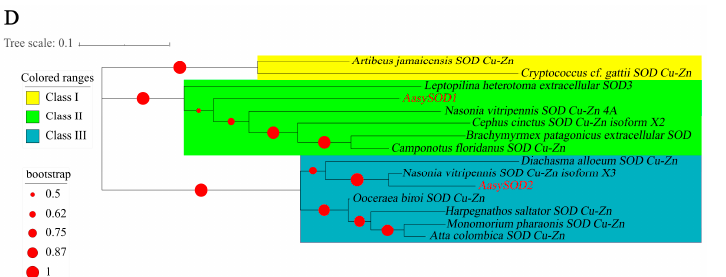
Figure 2. Phylogenetic analysis of antioxidant enzymes in insects: ( A ) catalase; ( B ) glutathione-S-transferases; ( C ) peroxidases; ( D ) superoxide dismutase.